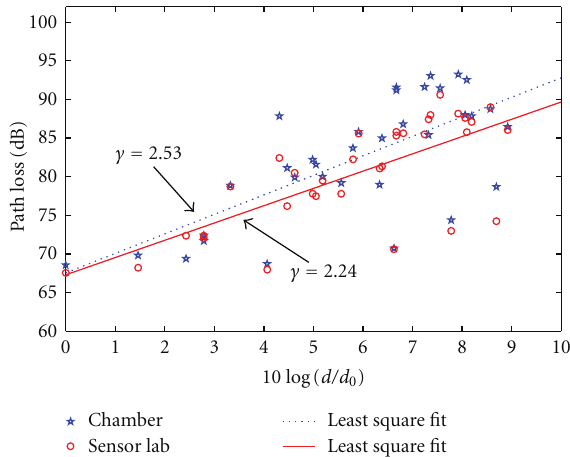
Figure 9: Measured and modelled path loss for on-body channel versus logarithmic Tx-Rx separation distance for UWB tags mea- sured in the chamber and in indoor environments.